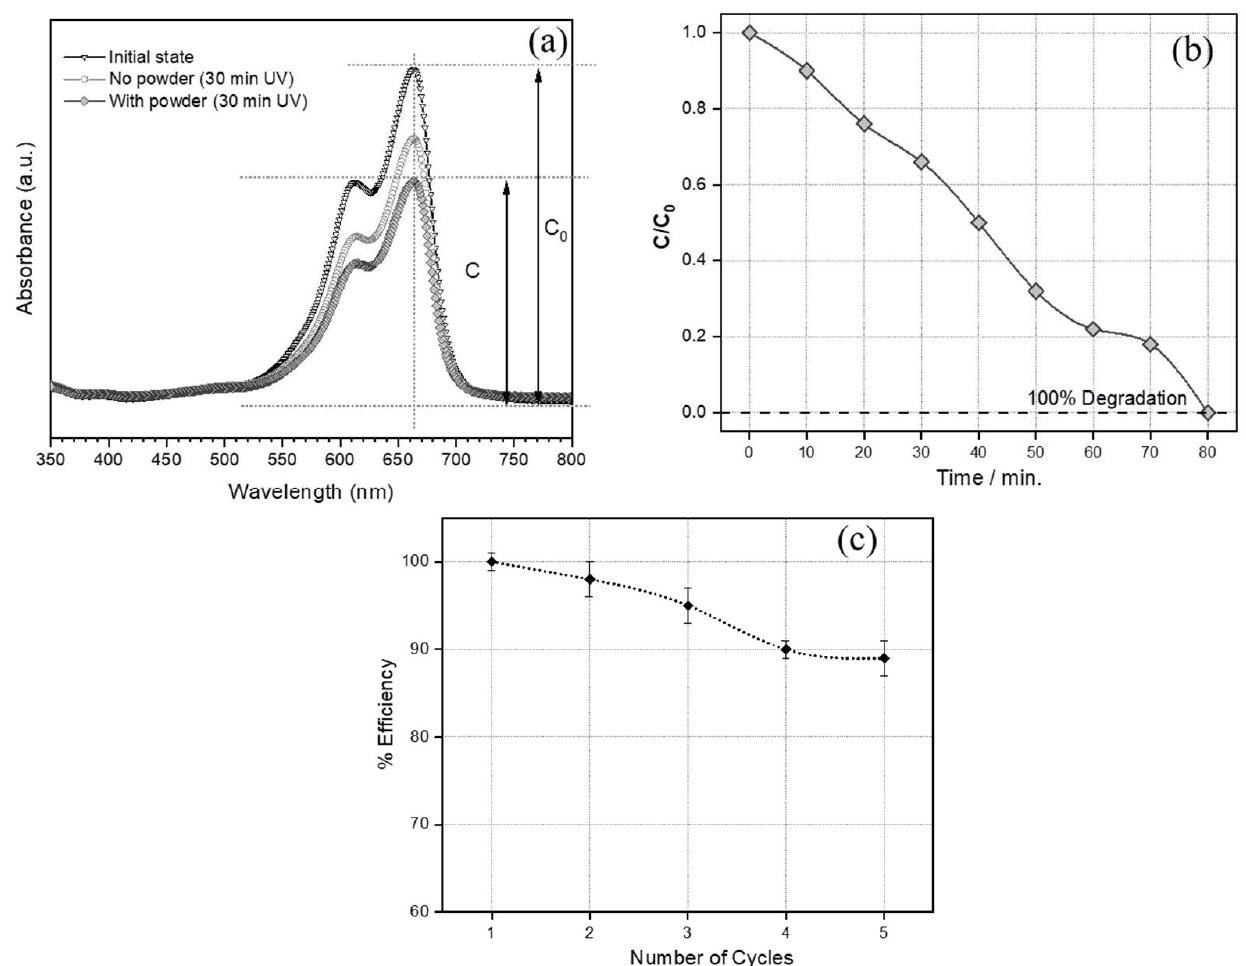
Figure 6. ( a ) Optical spectra of the methylene blue solution; ( b ) evolution of relative concentration of